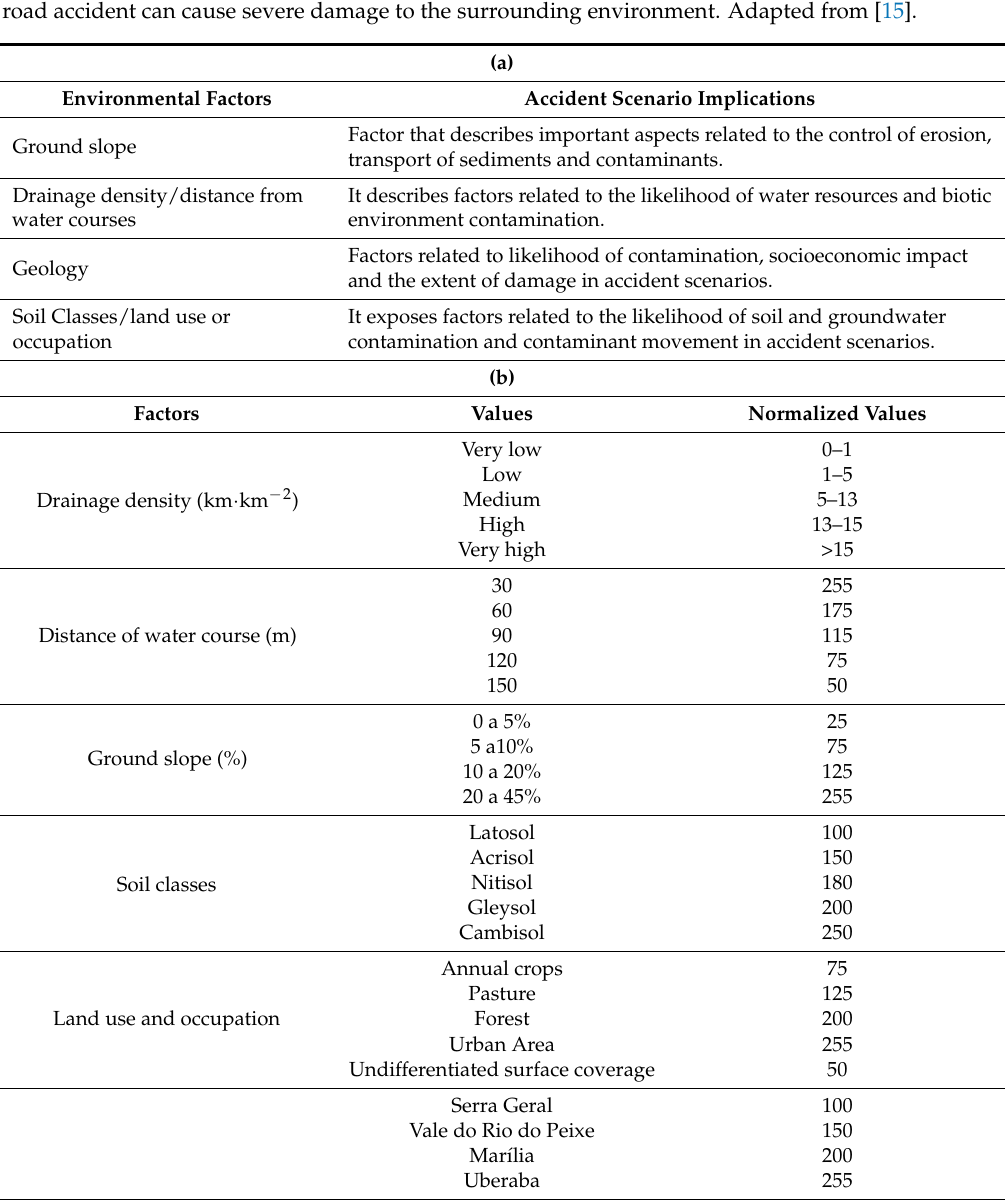
Table 1. ( a ) Factors used by [15] in the Multi Criteria Analysis of environmental vulnerability related to road accidents along the studied segment of BR 050 highway involving the transport of hazardous substances; ( b ) Normalization of factors within the Multi Criteria Analysis—MCA (step 2) designed to evaluate soil and water vulnerability along roads. The higher the value of a normalized factor the greater its importance for vulnerability. The MCA model was applied to a segment of BR 050 highway where transport of hazardous substances is intense and spills of those products following a road accident can cause severe damage to the surrounding environment. Adapted from [15]. (a) Environmental Factors Accident Scenario Implications Factor that describes important aspects related to the control of erosion, Ground slope transport of sediments and contaminants. Drainage density/distance from It describes factors related to the likelihood of water resources and biotic water courses environment contamination. Factors related to likelihood of contamination, socioeconomic impact Geology and the extent of damage in accident